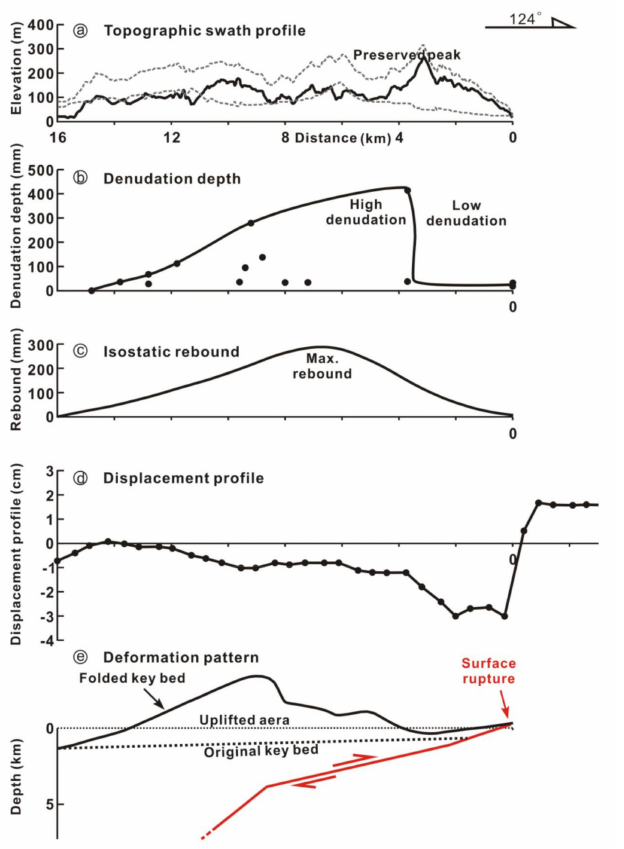
Figure 9. The topography swath profile, denudation depth, predicted isotatic rebound, displacement profile and deformation pattern associated with folding related to the Muikamachi fault. The relief is obtained by differencing the maximum and minimum profiles (dashed grey line) ( a ). The denudation depth profile is extracted from the catchment-scale average denudation map ( b ). The isostatic rebound is predicted based on the model by Champagnac et al. [62] ( c ). The post-seismic displacement [69] profile was modified from Ozawa et al. [65] and the SAR data used to generate the interferogram was acquired in 25 days of the main shock on 24 October 2004 [65] ( d ). The deformation pattern was modified from [37,43,44] ( e ). Red line is the Muikamachi fault